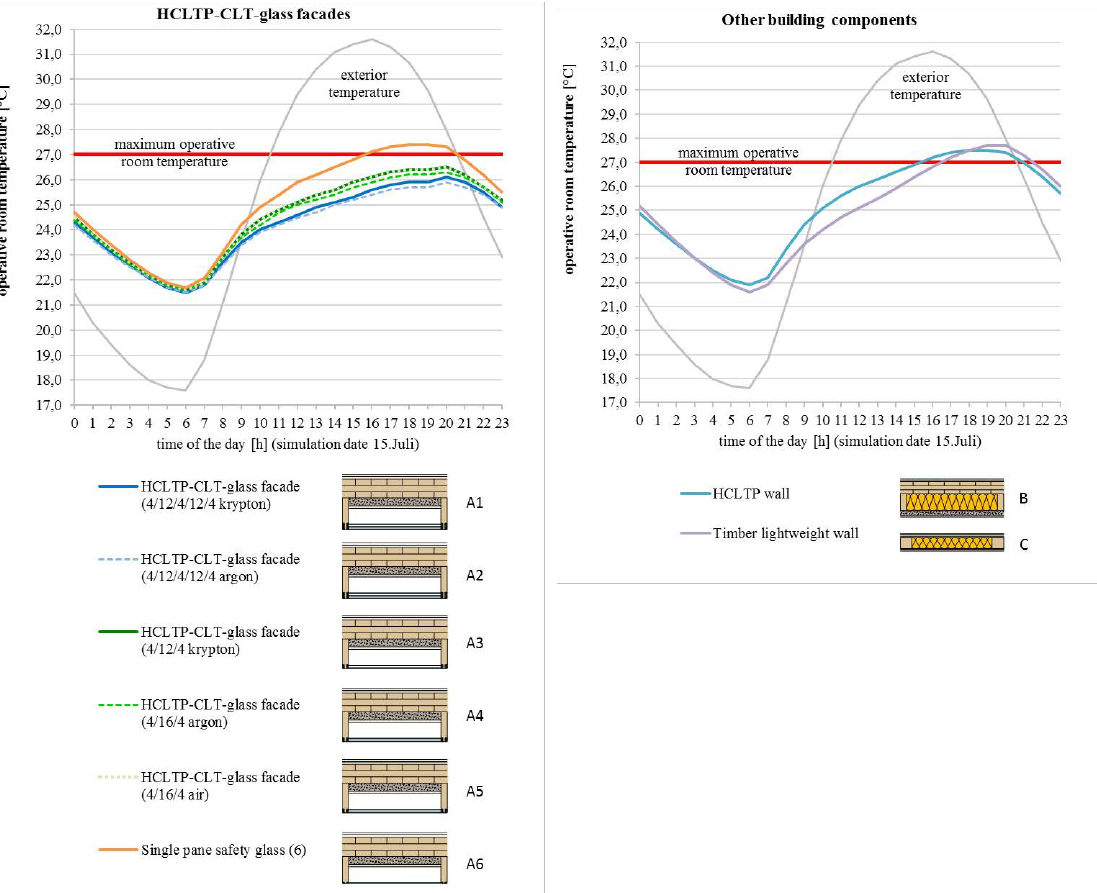
Fig. 5 Operative room temperature of the different